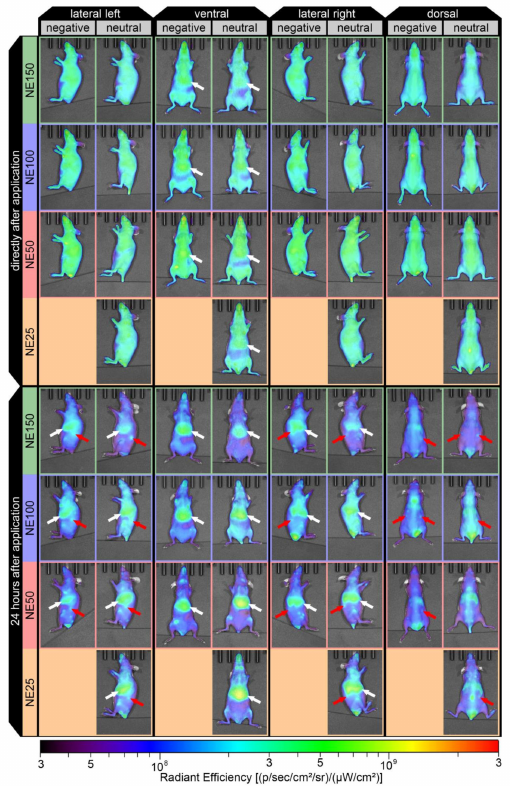
Figure 9. Noninvasive in vivo fluorescence images of the representative mice directly after (5–10 min) and 24 h after i.v. injection with the three negatively surface-charged nanoemulsions and an additional four previously investigated neutral surface-charged nanoemulsions